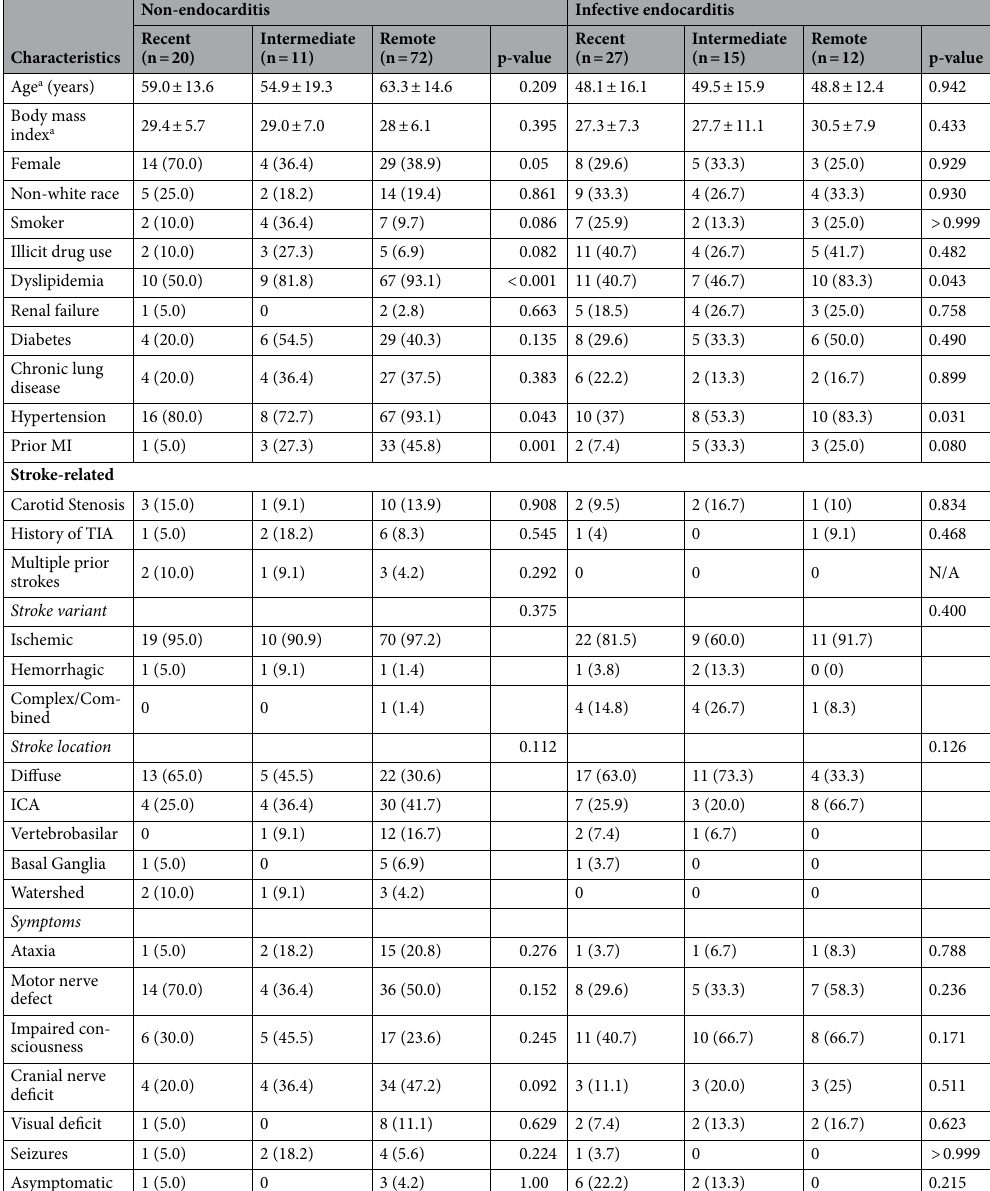
Table 1. Baseline demographics and pre-operative stroke-related characteristics by endocarditis cohort and stroke timing subgroup. Values are expressed as number (%) unless otherwise indicated. ICA internal carotid artery, MI myocardial infarction, TIA transient ischemic attack. a Mean ± standard